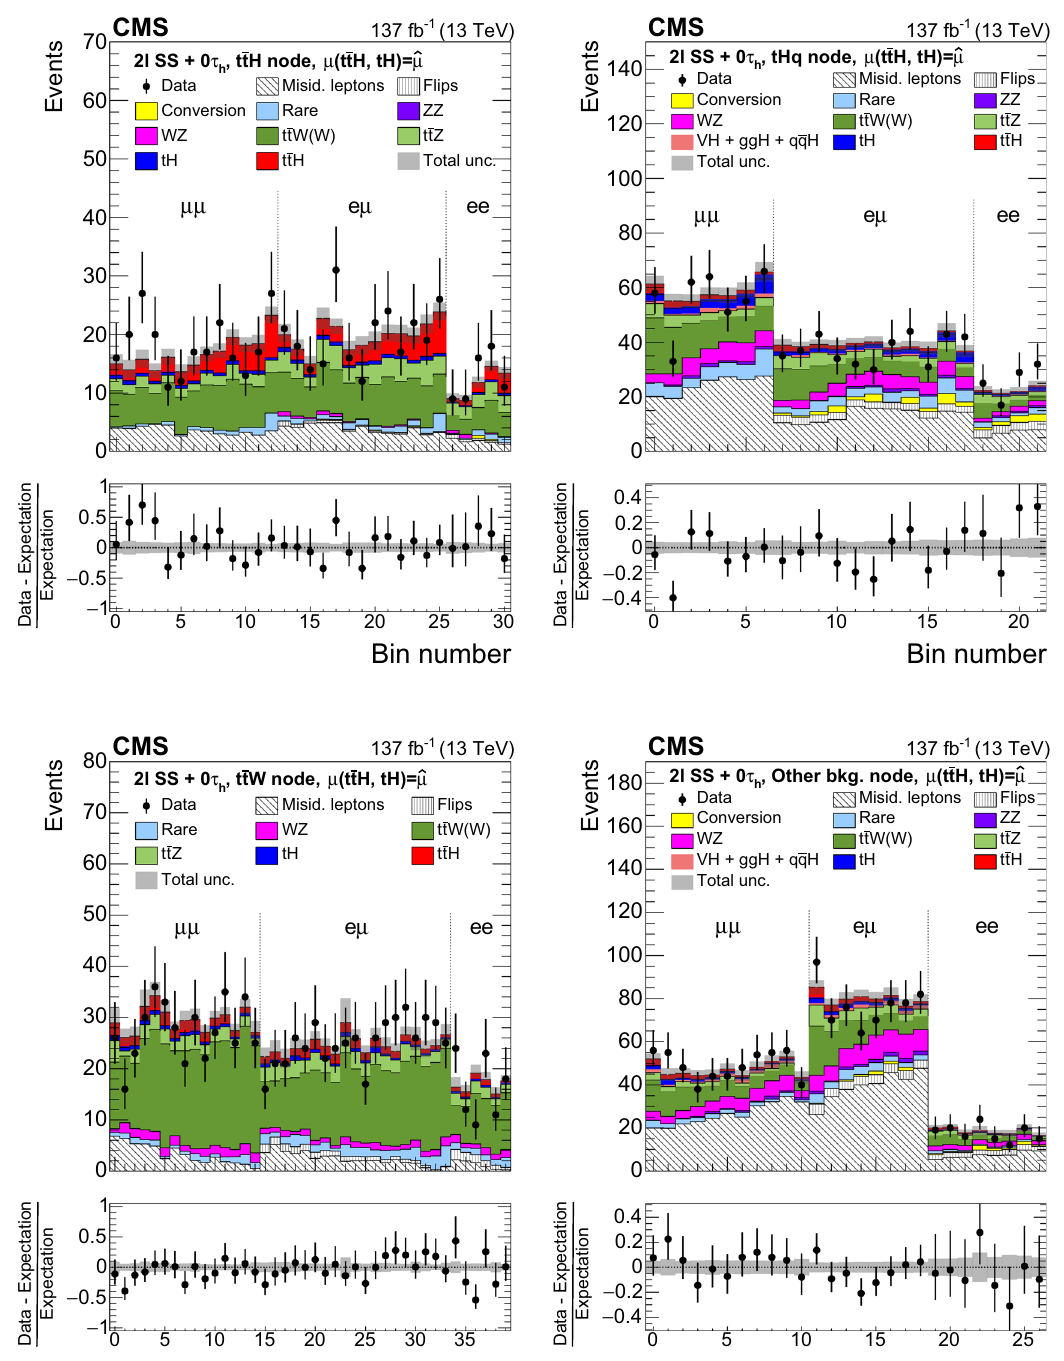
Fig. 8 Distributions of the activation value of the ANN output node with the highest activation value for events selected in the 2 (cid:4) SS + 0 τ h channel and classified as ttH signal (upper left), tH signal (upper right), ttW background (lower left), and other backgrounds (lower right). The distributions expected for the t tH and tH signals and for background